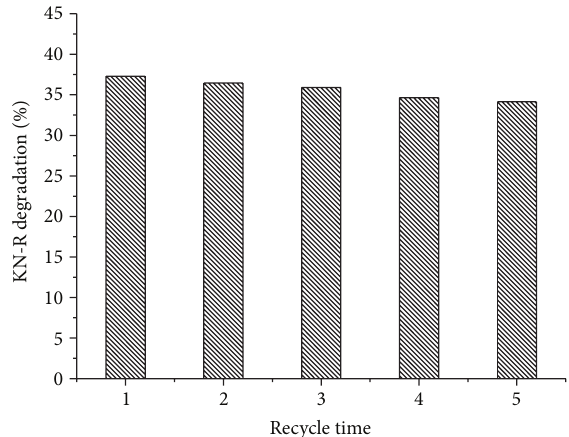
Figure 6: The photocatalytic cycling tests of N-doped ZnO/ZnS composite obtained under optimum conditions (Zn/N = 1: 1 and heat treated at 400 ∘ C for 2